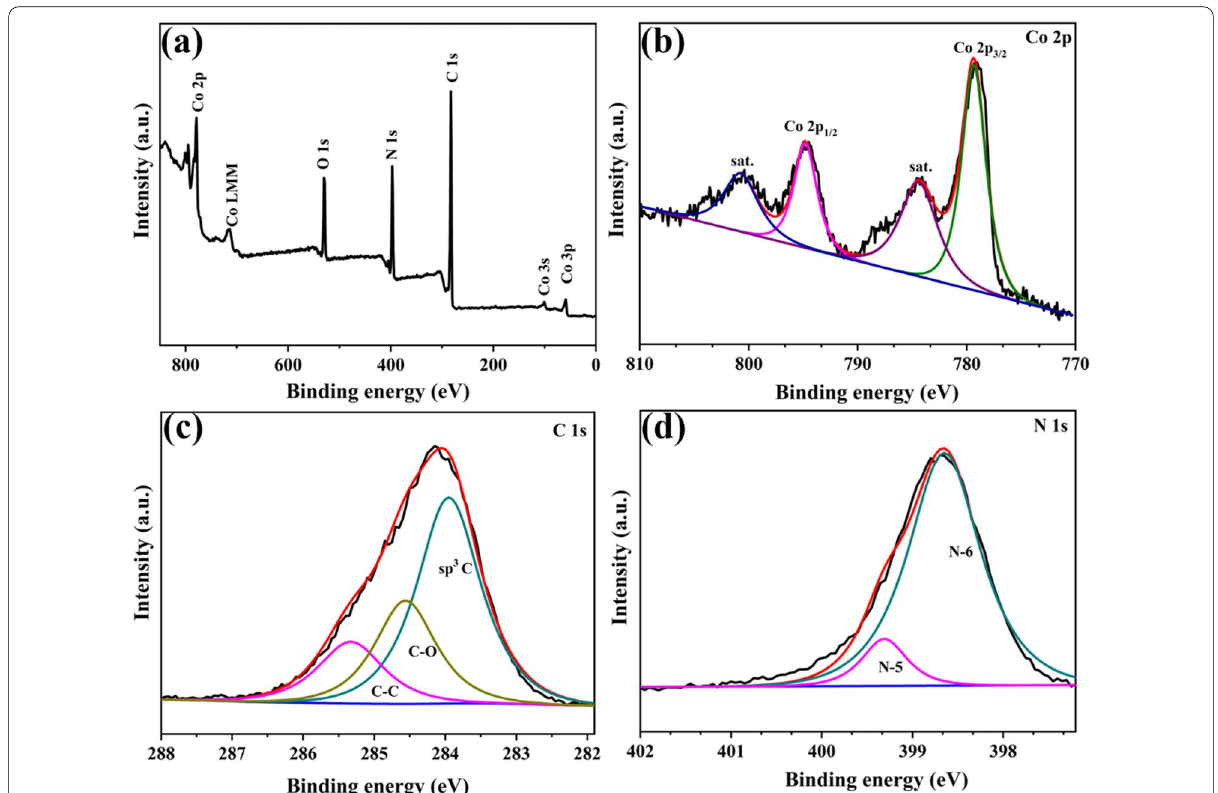
Fig. 2 XPS spectrum of the as-prepared ZIF-67/cotton fibers ( a ) and corresponding high-resolution spectra: Co 2p ( b ), C 1 s ( c ) and N 1 s ( d